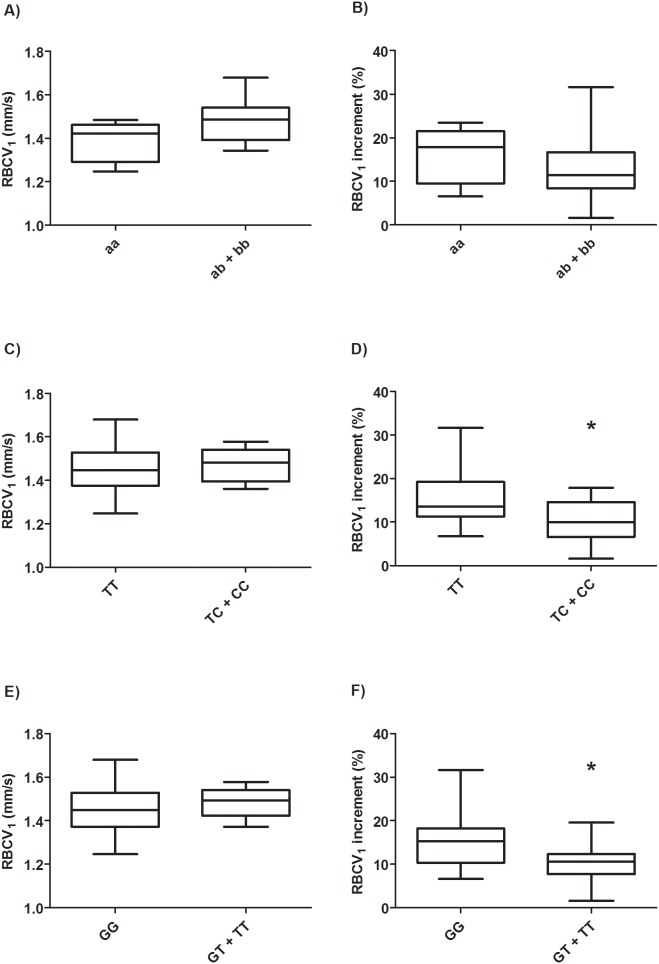
RBCV1 and RBCV1 increment in HD women according to NOS3 T-786C and G894T genotypes.Data are presented as Whiskers plot. Comparison between groups was made by Mann Whitney test. RBCV1: Red blood cells velocity (mm/s). RBCV1 increment: Red blood cells velocity increment (%) after 1 min ischemia and subsequent reactive hyperemia response upon occlusion release. A, C, and E, RBCV1 and VNTR, -786C, and G894T genotypes, respectively. B, D, and F, RBCV1 increment and VNTR, -
786C, and G894T genotypes, respectively.